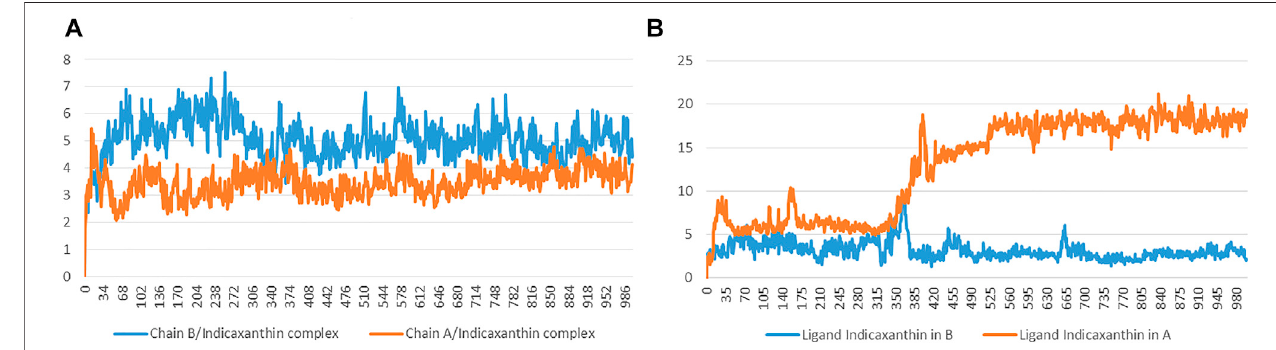
FIGURE 7 | The comparative RMSF values for the complexes of backbone atoms of Chain A (A) and Chain B (B) bound to K252a, Indicaxanthin, and of the allosteric pocket.